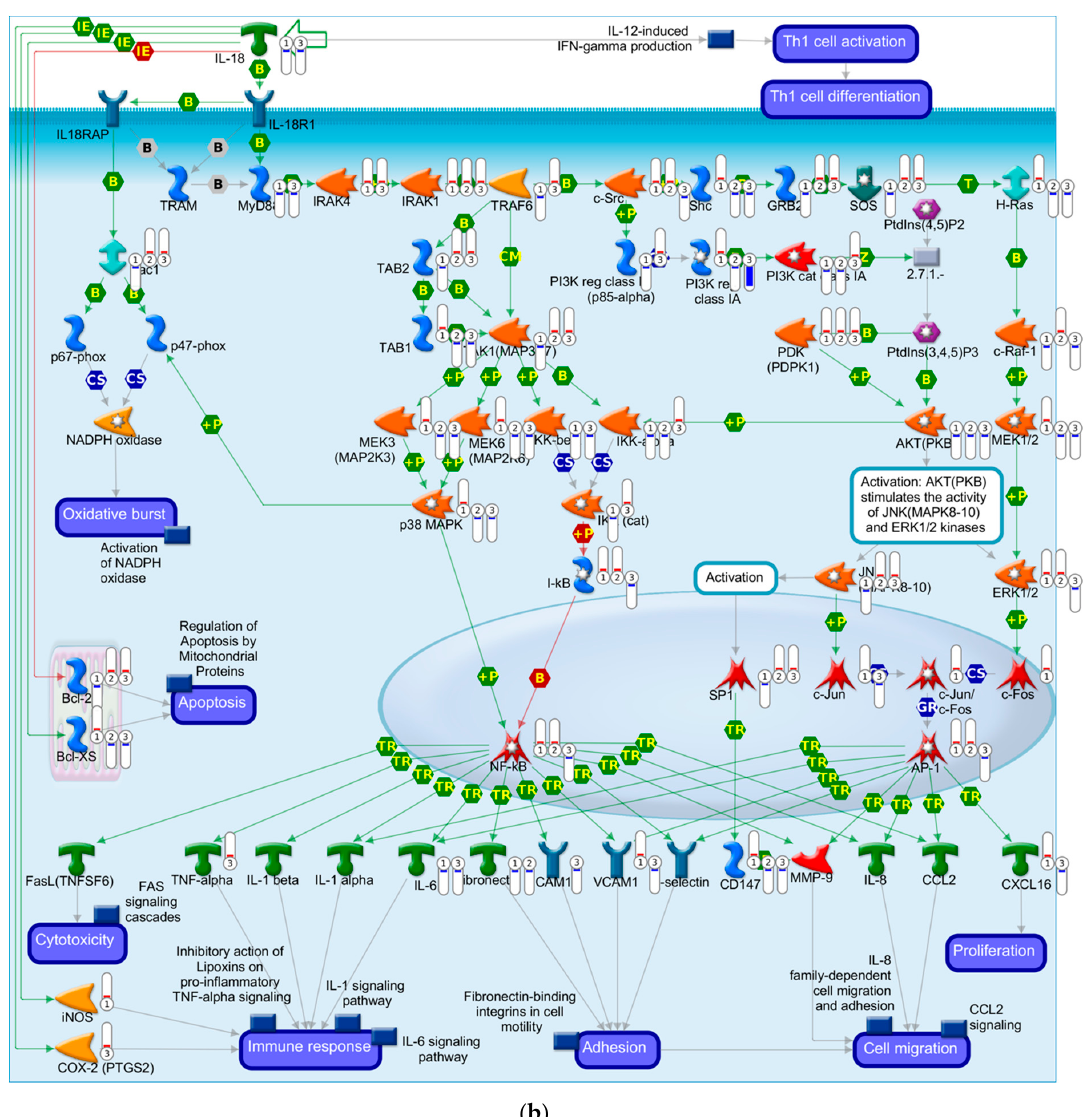
Figure 4. Schematically illustrated MetaCore pathway associated with dengue and liver failure. Differentially expressed genes (DEGs) from cells after DENV-infection and/or APAP-treatment were mapped to the MetaCore pathways: ( a ) “Immune response—Role of Protein Kinase regulated by double-stranded RNA (PKR) in stress-induced antiviral cell response” that is the main canonical pathway associated with dengue; ( b ) “Immune response—Interleukin-18 (IL-18) signaling” that is the main canonical pathway associated with liver failure. The thermometers in the figure indicate the DEGs in cells after DENV-infection and APAP-treatment (1), DENV-infection (2), and APAP-treatment (3). The red columns indicate upregulation and the blue columns indicate downregulation. Further details can be accessed at https://portal.genego.com/help/MC_legend.pdf.